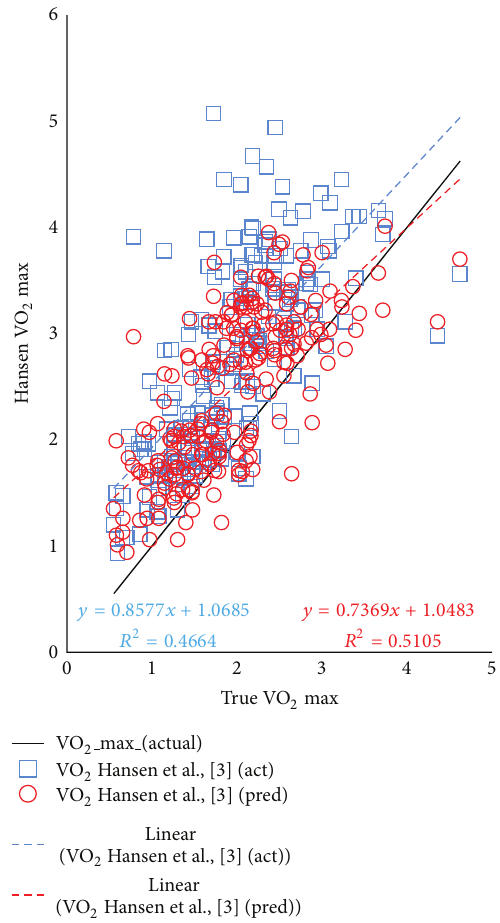
Figure 2: Comparison among regression lines for the Hansen algorithm using either actual or ideal body weights to predict VO 2 max.